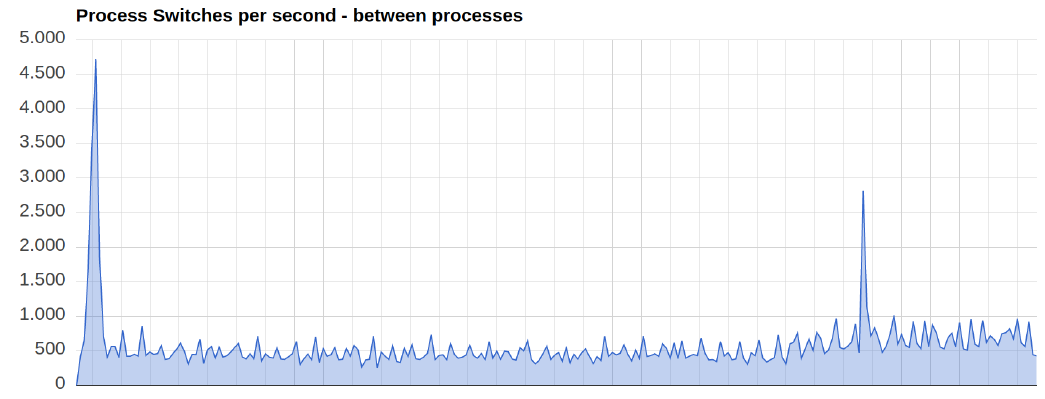
Figure 4. CPU utilization in one of the Raspberries.